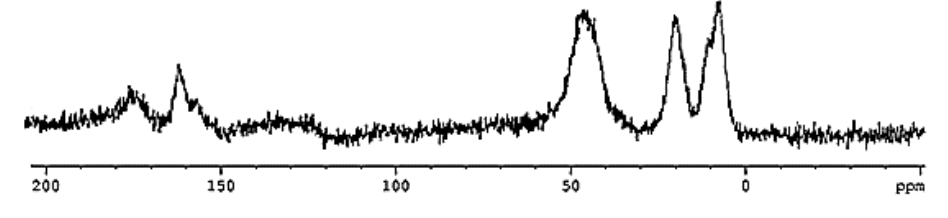
Figure 2. CP-MAS 13 C NMR spectrum of Cu-L@SBA-15. Figure 2. CP ‐ MAS 13 C NMR spectrum of Cu ‐ L@SBA ‐ 15. Figure 2. CP ‐ MAS 13 C NMR spectrum of Cu ‐ L@SBA ‐ 15.